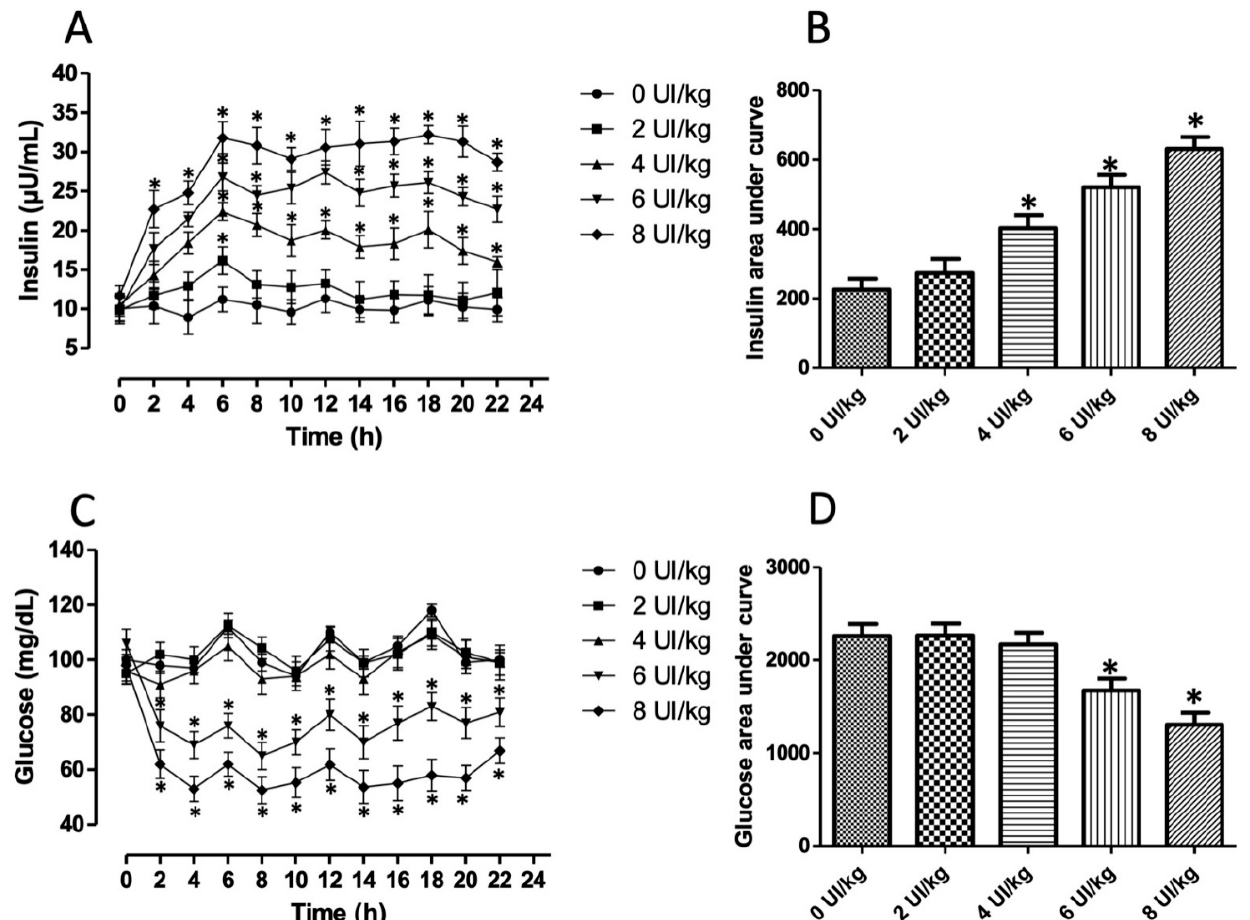
Figure 1. Effect of administering different doses of glargine on insulin and glucose concentration throughout the day. ( A ) Serum insulin concentration after insulin administration. ( B ) Area under curve of the insulin concentration. ( C ) Serum glucose concentration after insulin administration. ( D ) Area under curve of the glucose concentration. The results shown are the average of 10 different experiments ± SEM. ( A , C ) graphs were analyzed by a two-way ANOVA followed by a Bonferroni test. ( B , D ) graphs were analyzed by a One-way ANOVA followed by a Tukey’s post-test. (*) indicates significant difference regarding 0 UI/kg group, p ≤ 0.05.